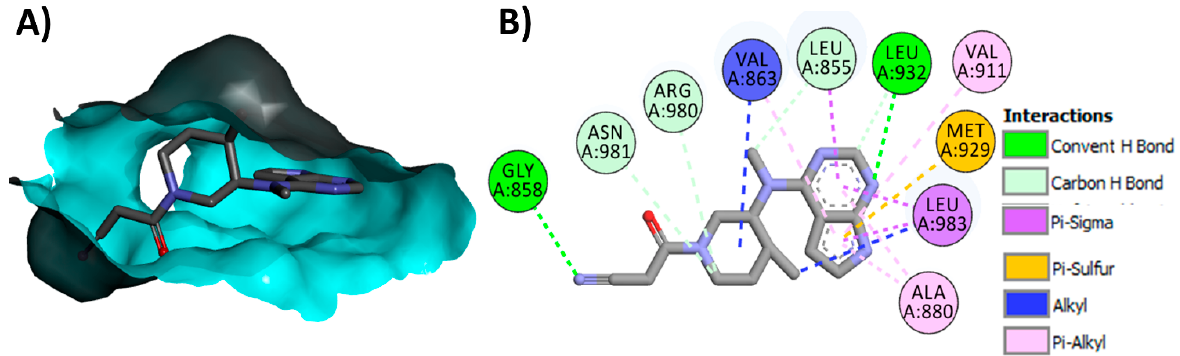
Figure 61. Binding modes of tofacitinib (shown as sticks) into JAK2 (pdb: 3FUP): ( A ) 3D binding mode, receptor shown as a hydrogen bond surface; ( B ) 2D binding mode showing different types of interactions with JAK2; hydrogen atoms were omitted for clarity; this figure was generated using Discovery Studio Visualizer (V16.1.0.15350).